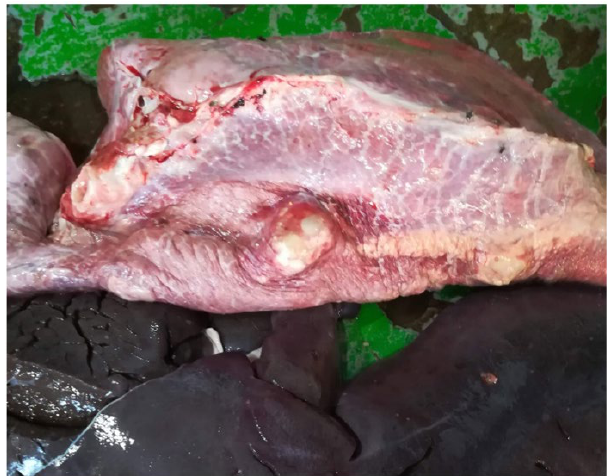
Figure 7. Superinfected pulmonary hydatid cyst (immune response in progress).